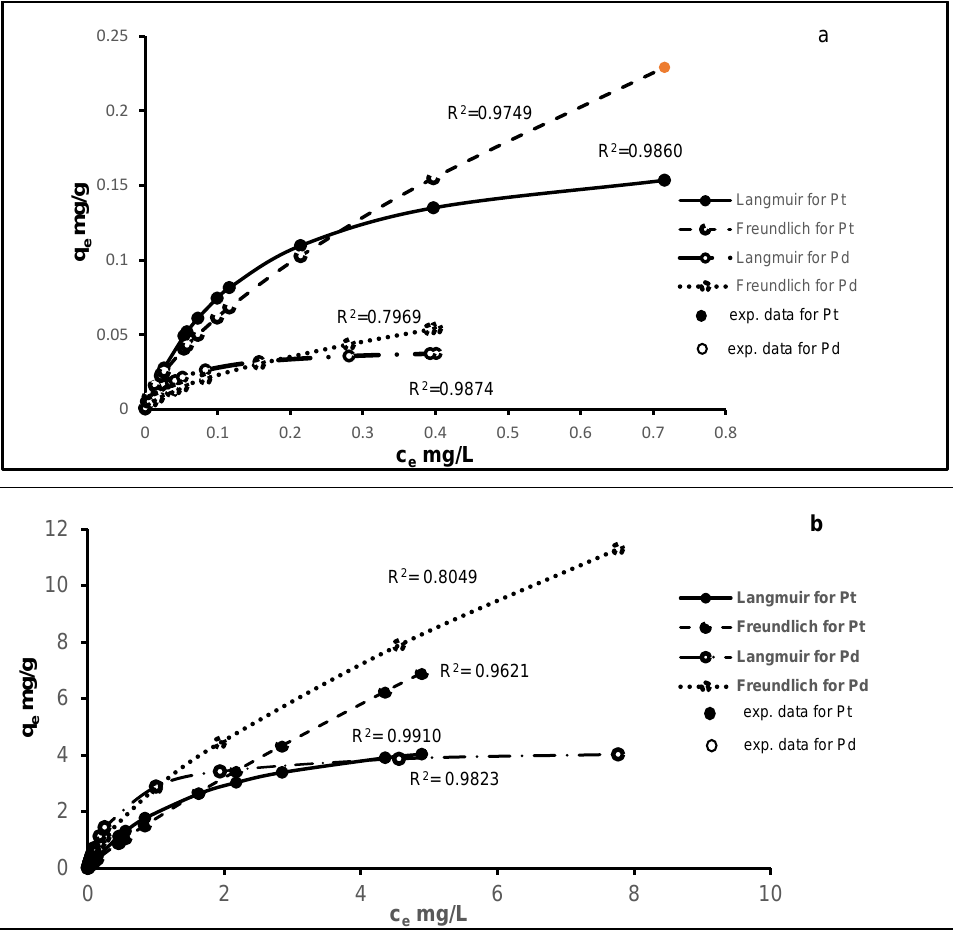
Figure 3. Sorption isotherms of Pt and Pd on ( a ) Saccharomyces sp. and ( b ) Aspergillus sp. Biosorption of Pt on yeast and fungi at pH 2, biosorption of Pd on yeast at pH 2.5, on fungi at pH 3.5, dry biomass 0.013 g, contact time 45 min.